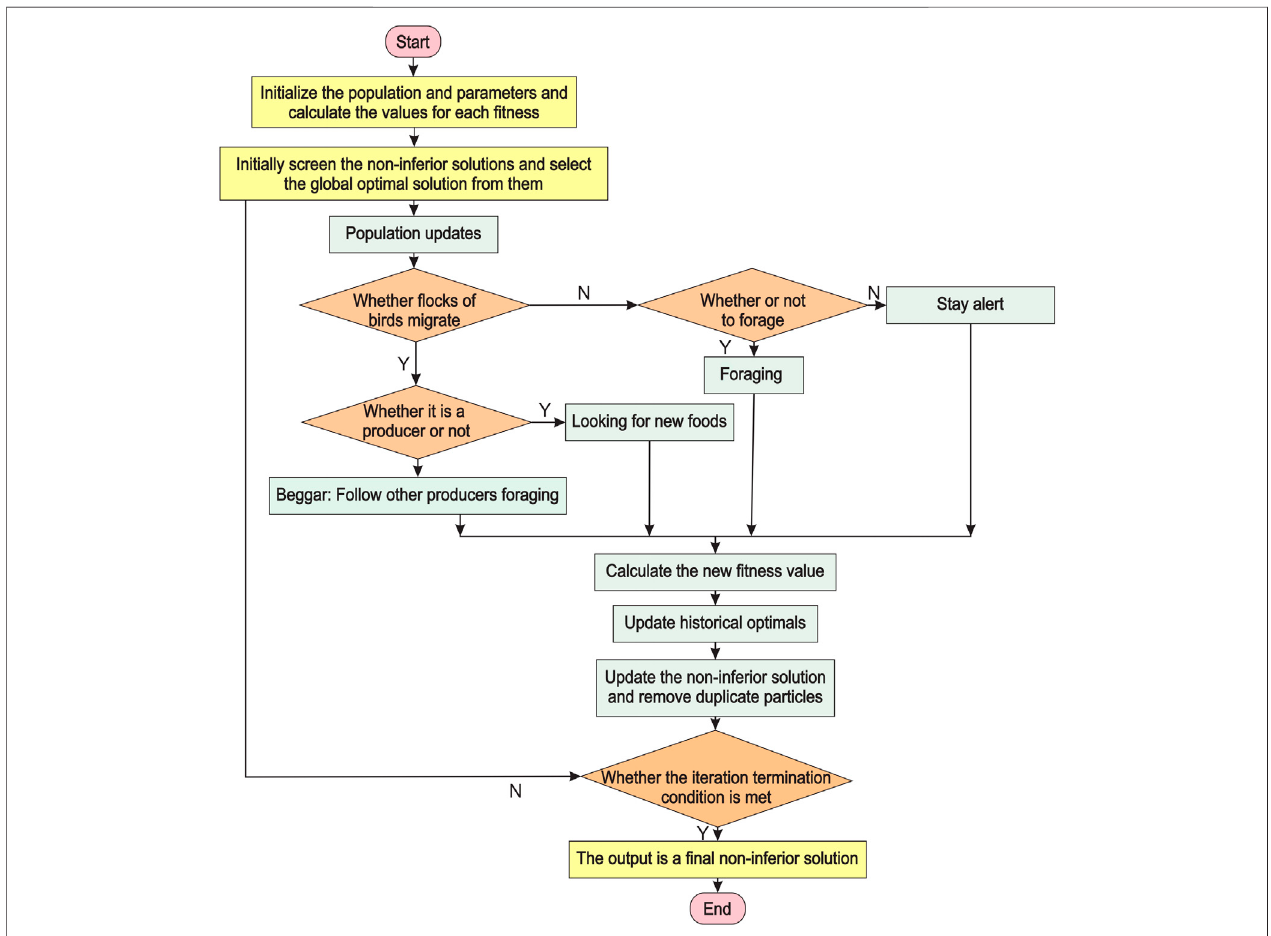
FIGURE 3 | Flow chart of the bird swarm